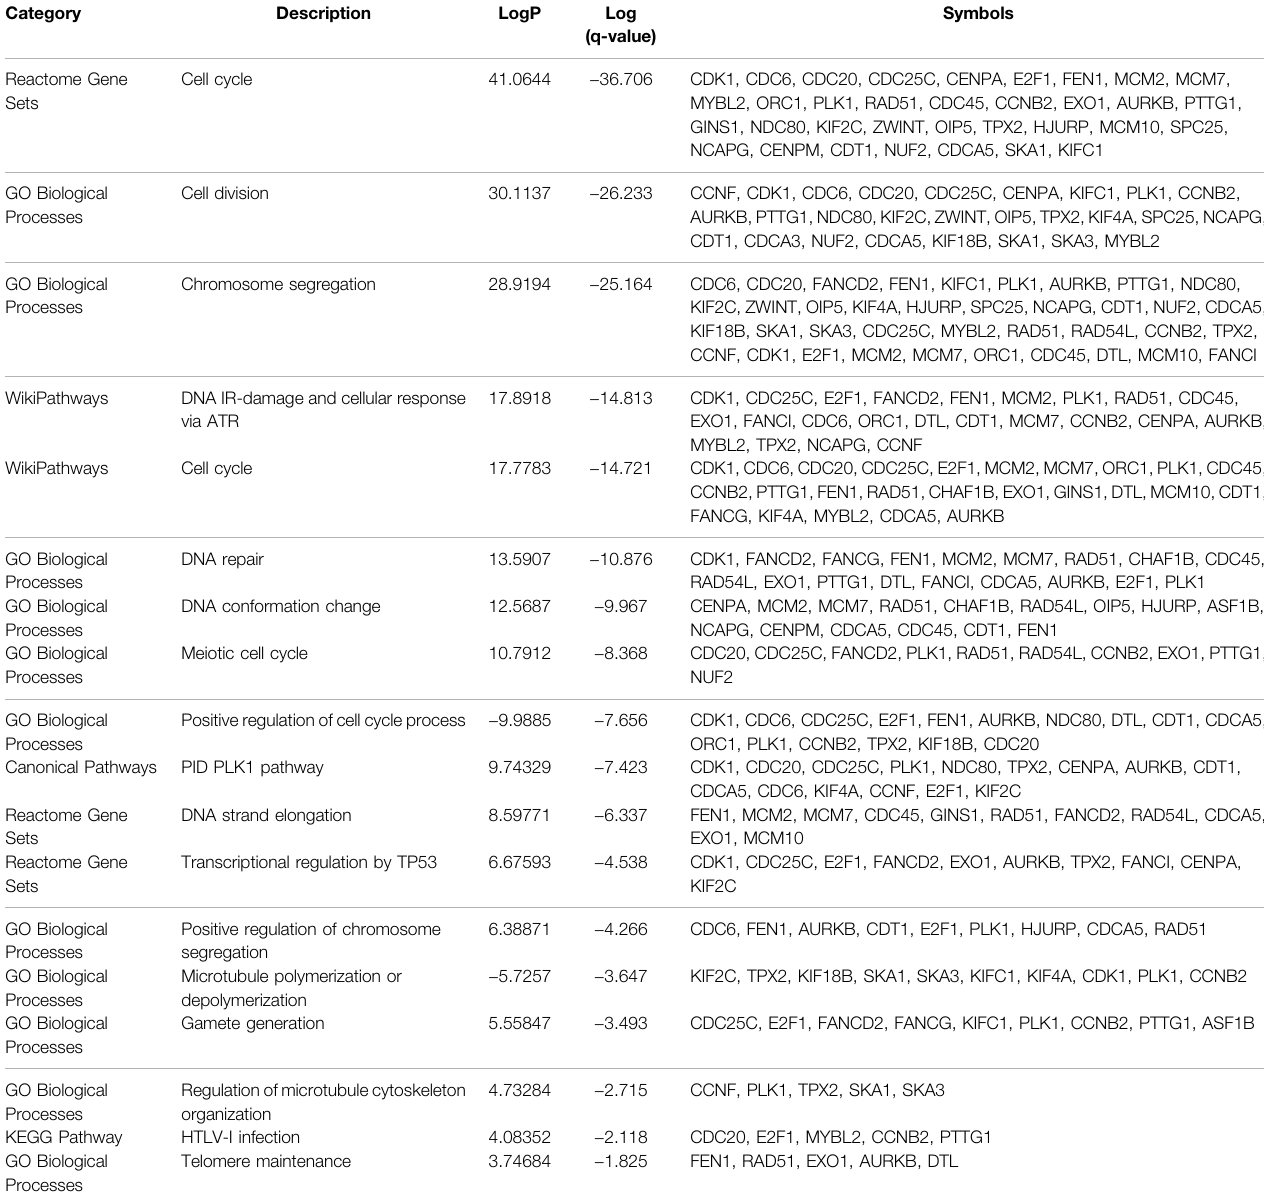
TABLE 2 | Top 18 clusters with their representative enriched terms by Metascape.